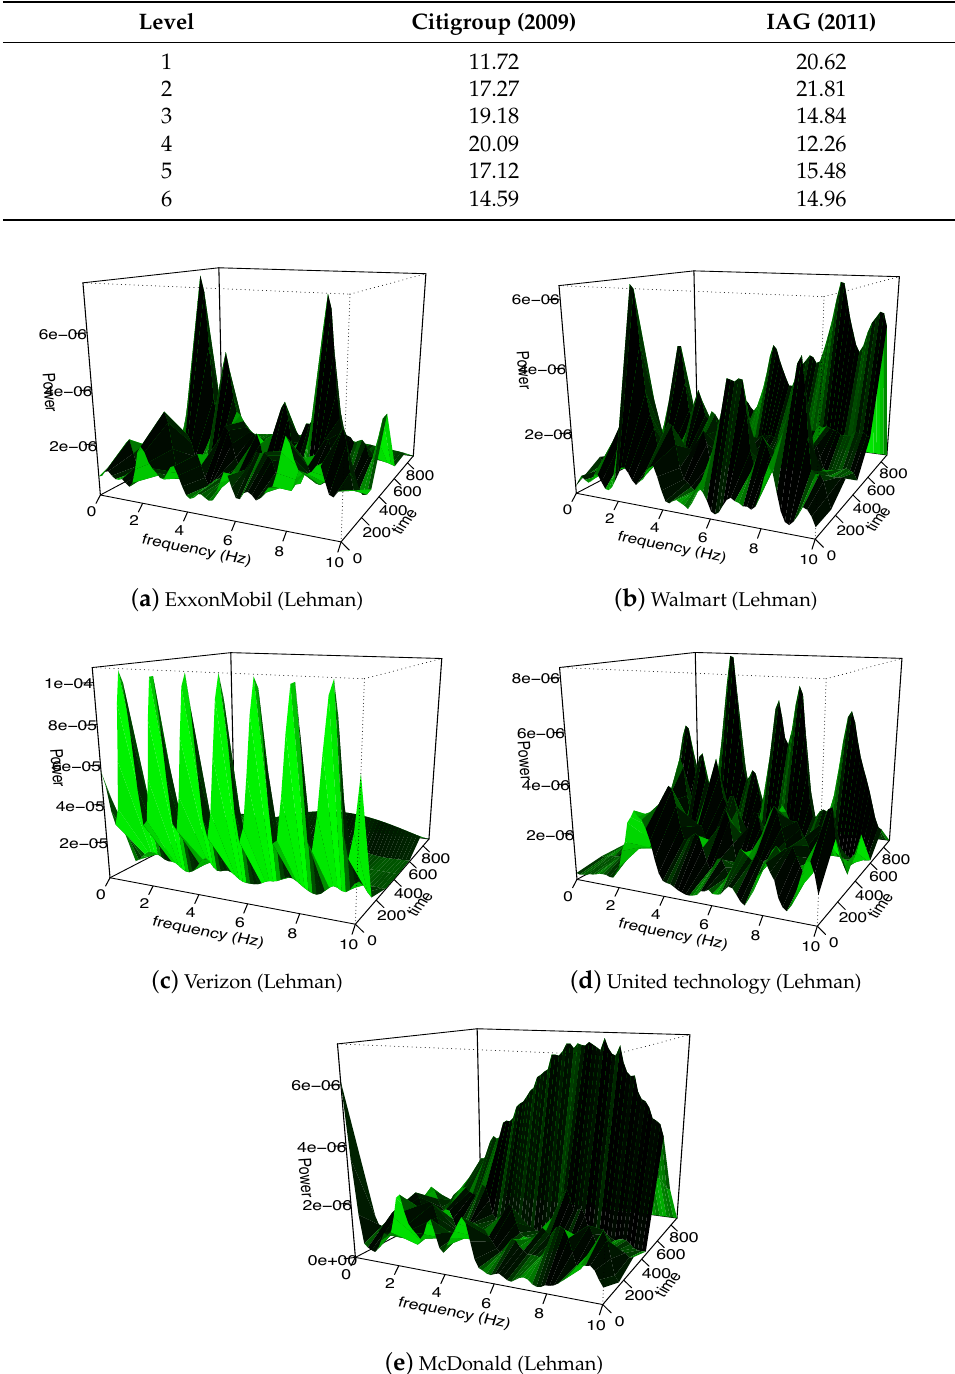
Figure 1. 3D power spectra of the financial data corresponding to the Lehman Brothers